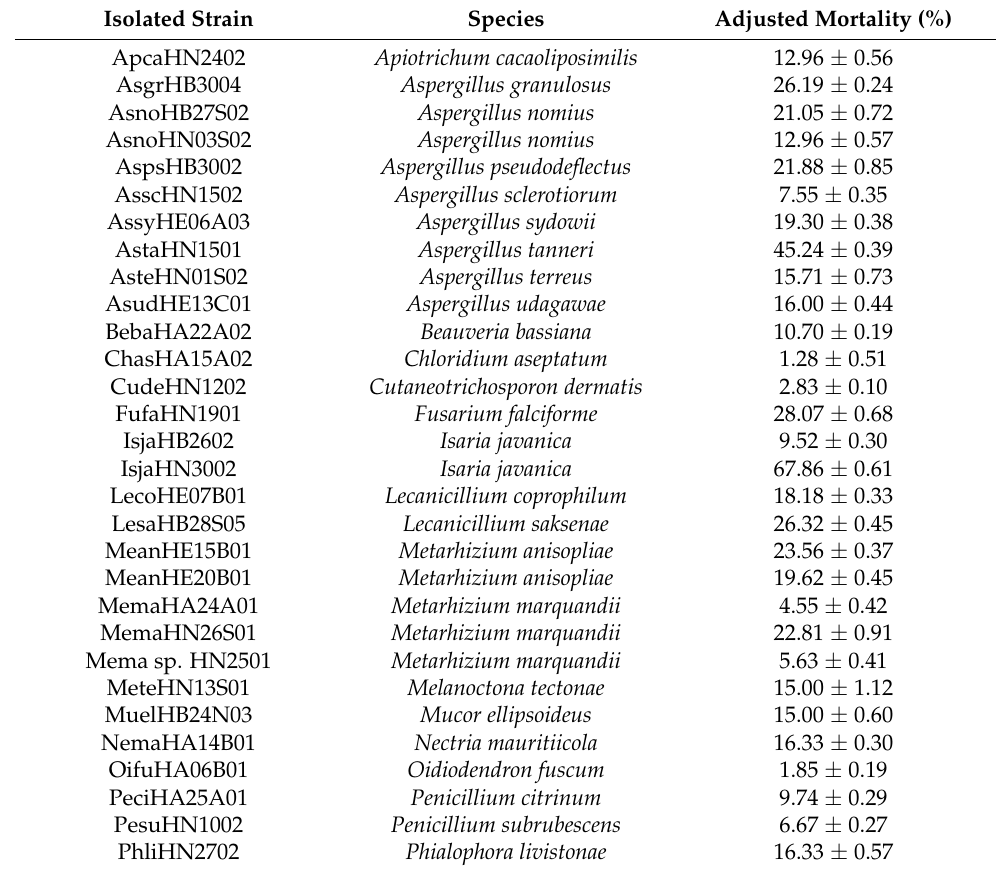
Table 4. The pathogenicity of fungal isolates against adults of P. striolata